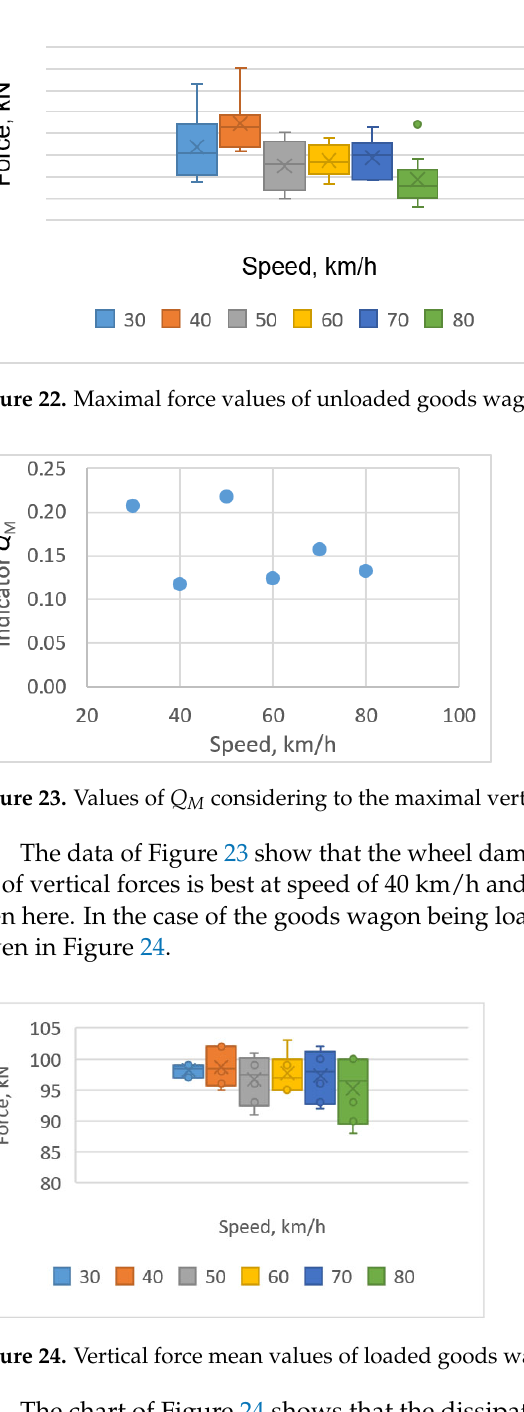
Figure 21. Values Q M considering the loaded wagon maximal vertical forces.